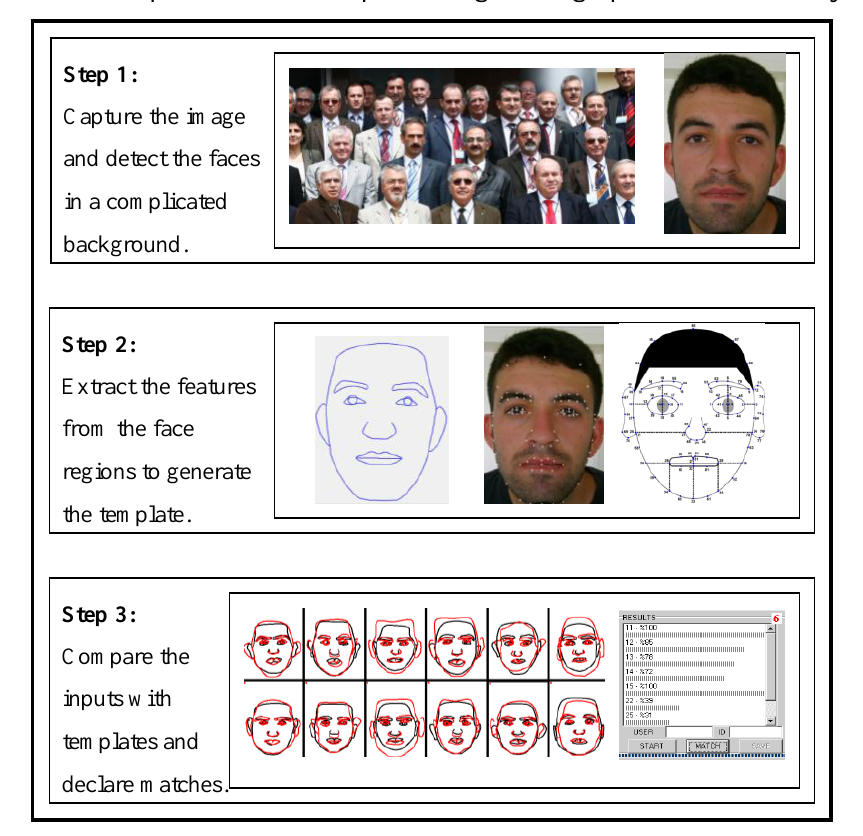
Figure 4. Main processes of face processing for fingerprint to face task